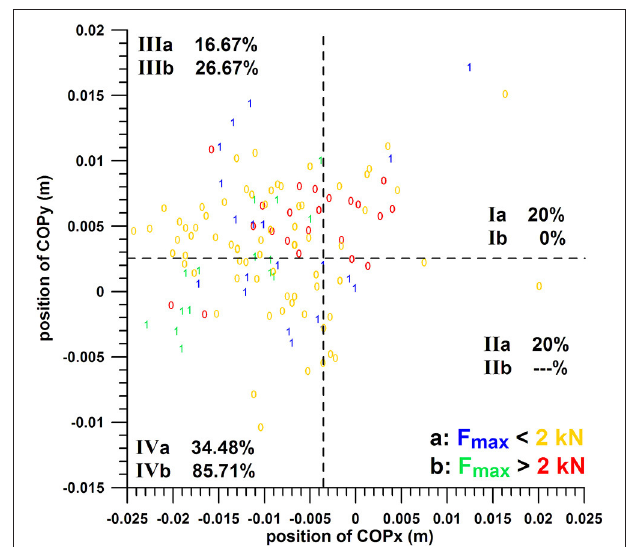
FIGURE 8 | Two-parameter analysis: COPx vs. Fmax (peak impact force); 0 = miss, 1 = hit; dashed lines = threshold values (cf. Table 1 ); I, II, III, IV = group codes from Table 2 .